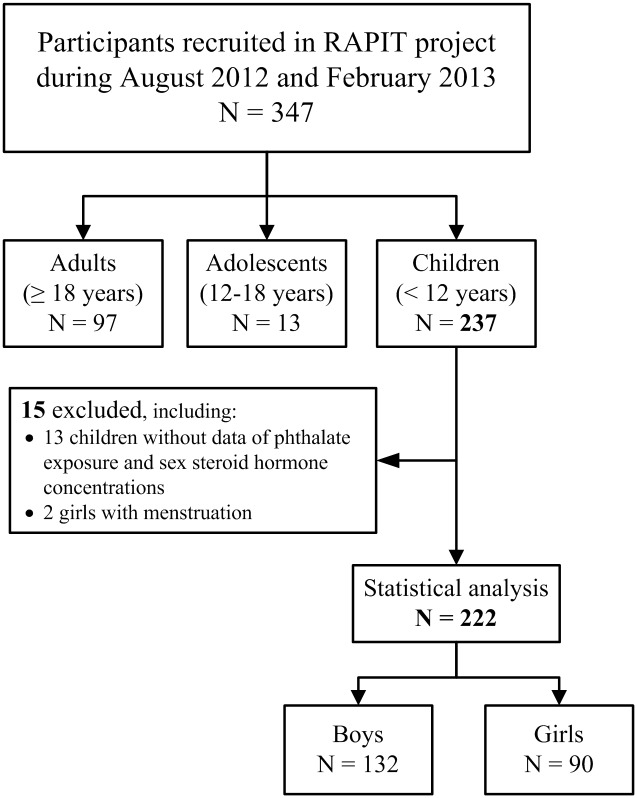
Flow chart of participant recruitment.